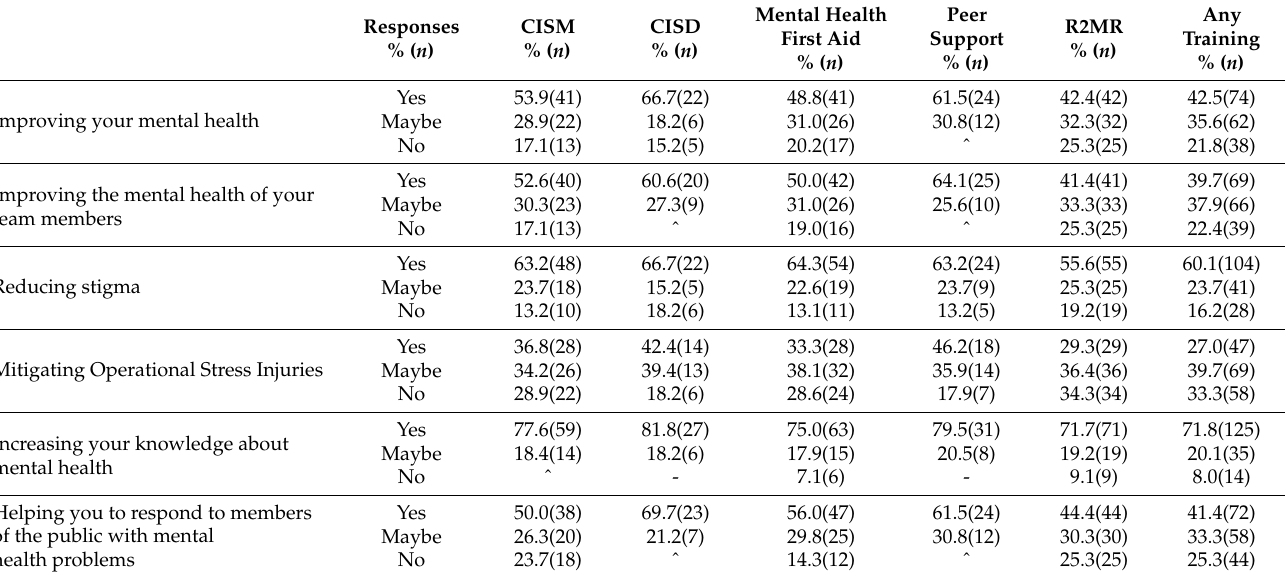
Table 5. Prevalence of mental health training categories and attitudes toward the effectiveness of